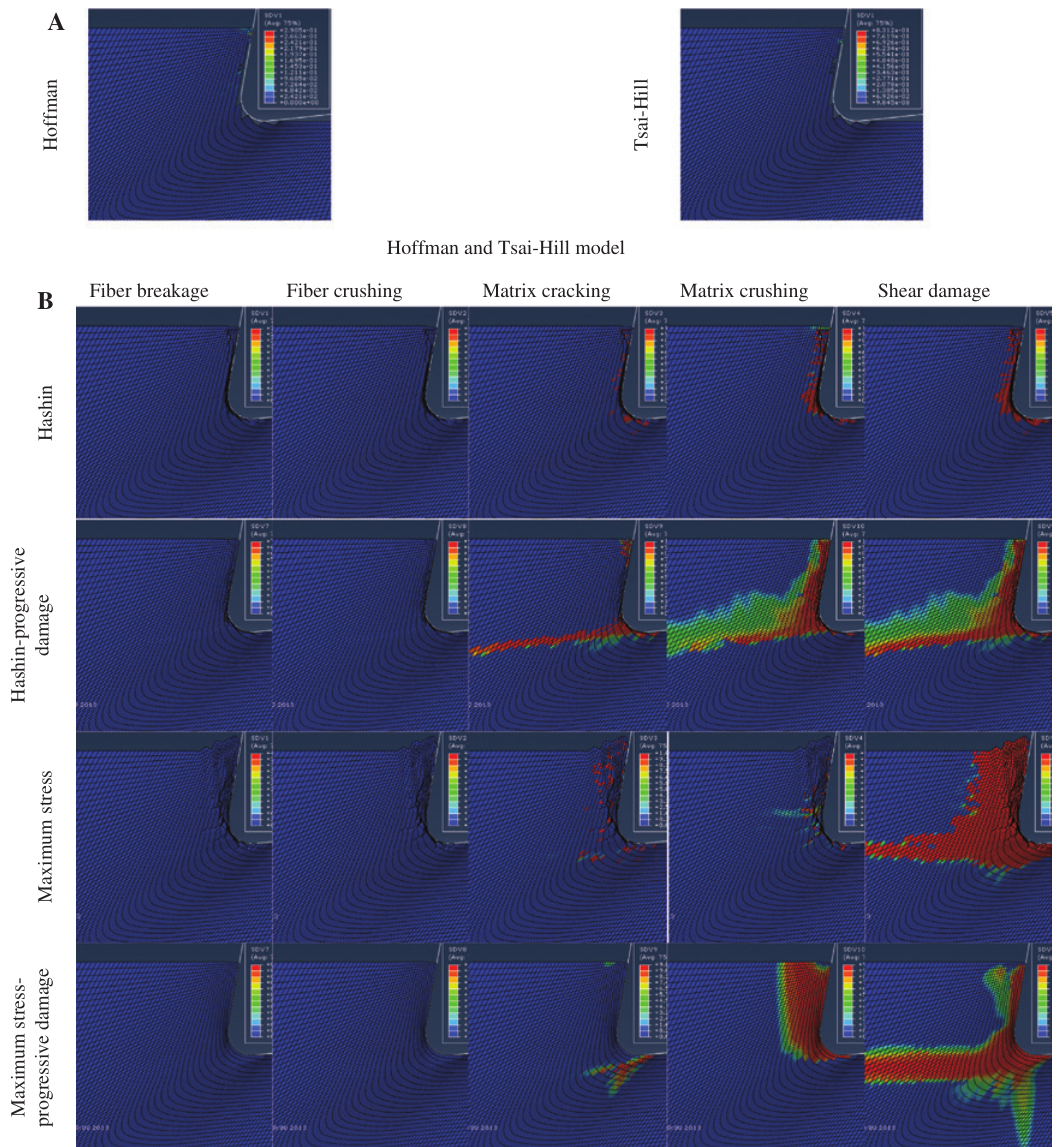
Figure 9: Sub-surface damage simulation (fiber orientation 90 ° , t = 5